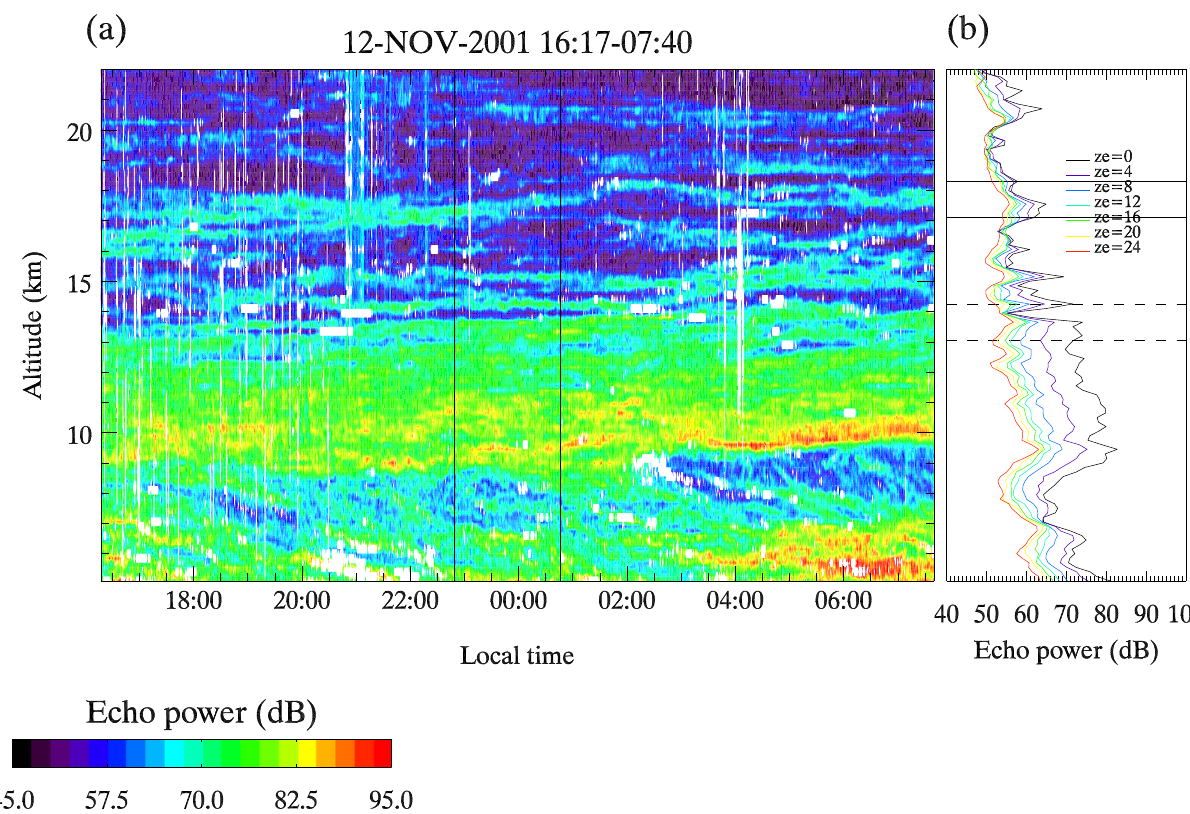
Fig. 2. (a) Time-height variations of the echo power and (b) height variations of the echo power averaged from 22:39 to 00:46LT corre- sponding to the period delimited by the two solid vertical lines in (a). The dotted and solid horizontal lines in (b) correspond to the analyzed ranges shown in Figs. 5a and b, respectively.